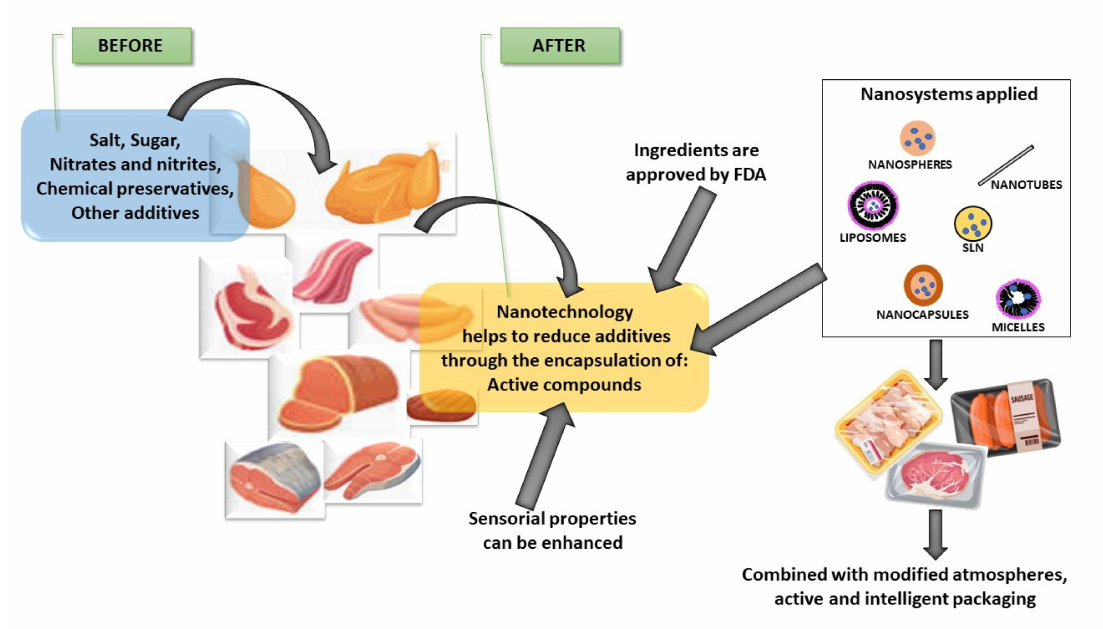
Figure 2. Technologies to improve the addition of additives in meat and meat